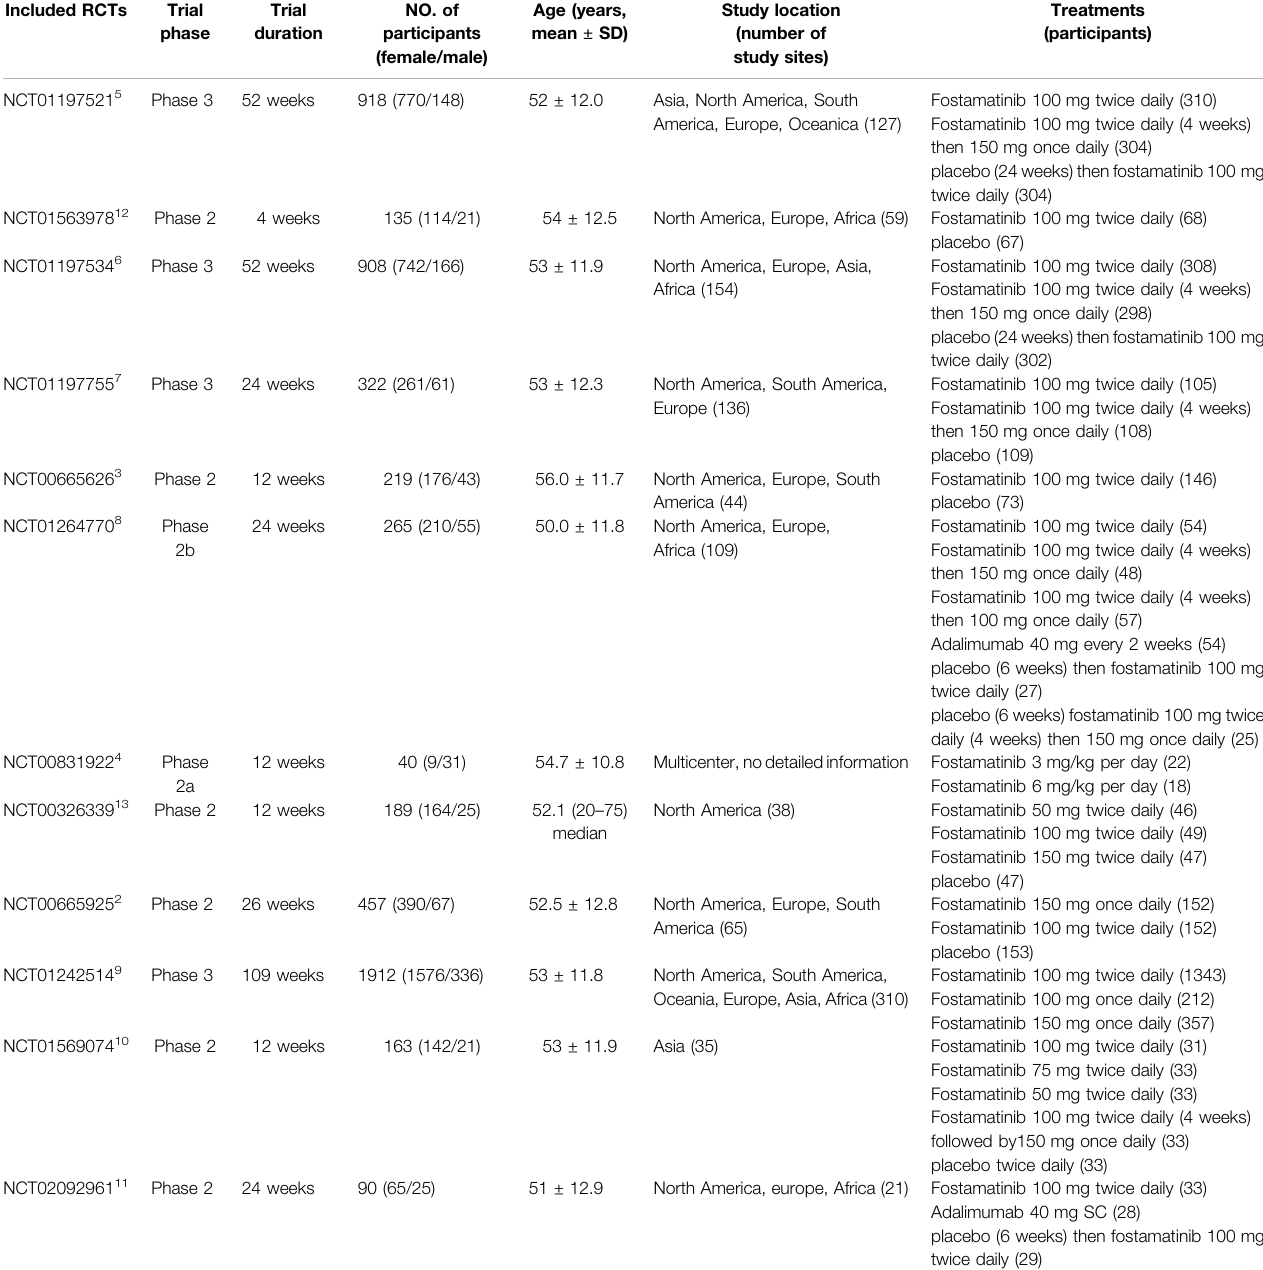
TABLE 1 | Characteristics of included